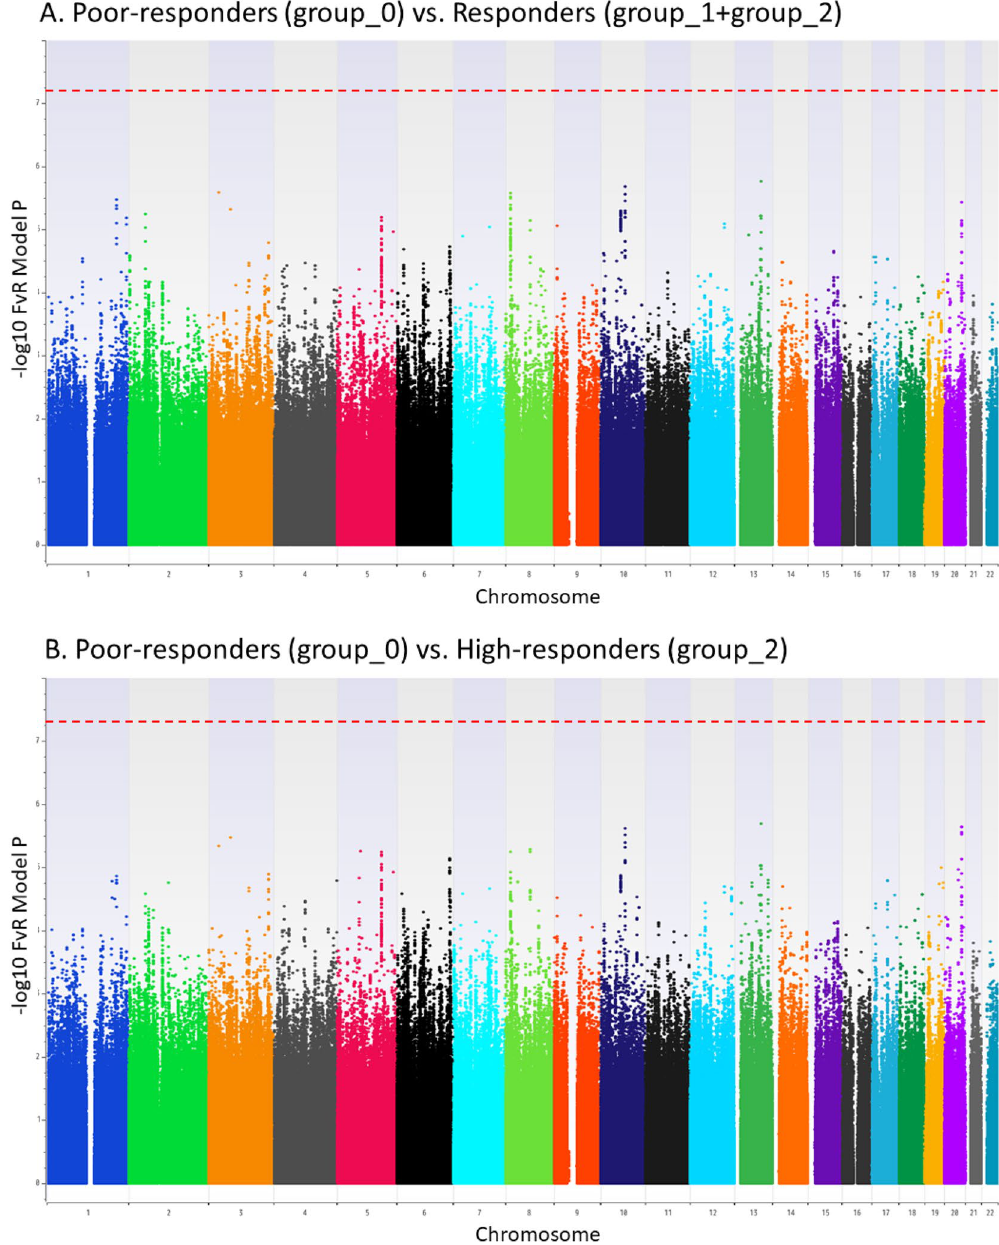
Figure 1. Manhattan plot from dense imputed data by applying a regression analysis with age, sex, and the number of vaccinations as covariates. Among 555 Japanese HB-vaccinated individuals with Heptavax-II, P values were calculated in a comparison ( A ) between poor-responders (n = 66) and responders (n = 489), and ( B ) between poor-responders and high-responders (n = 305) using a chi-square test for allele frequencies. Dashed lines indicate genome-wide significance levels of P = 5.0 × 10 –8